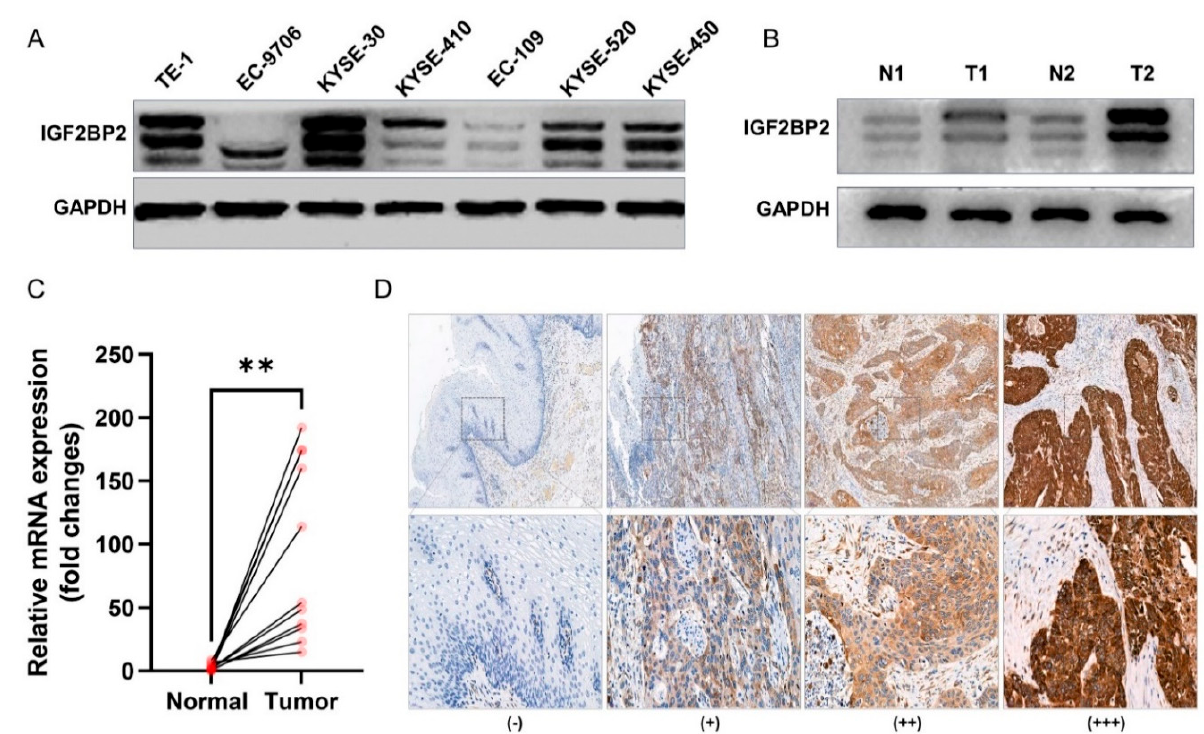
Figure 1. IGF2BP2 expression in ESCC cancer cell lines and tumor tissue. ( A ) Western blotting of IGF2BP2 in esophageal cancer cell lines. ( B ) Western blotting of IGF2BP2 in esophageal cancer tumor tissues (T) and normal tissues (N). ( C ) IGFBP2 mRNA expression in tumor tissues and normal tissues from 11 patients. ** p < 0.01. ( D ) Representative IHC staining images of IGF2BP2 expression in ESCC tissues. − : negative staining, +: weak positive, ++: medium positive, +++: strong positive. Magnification, up 50×, down 200×. Table 1. The basic characteristics of ESCC patients.